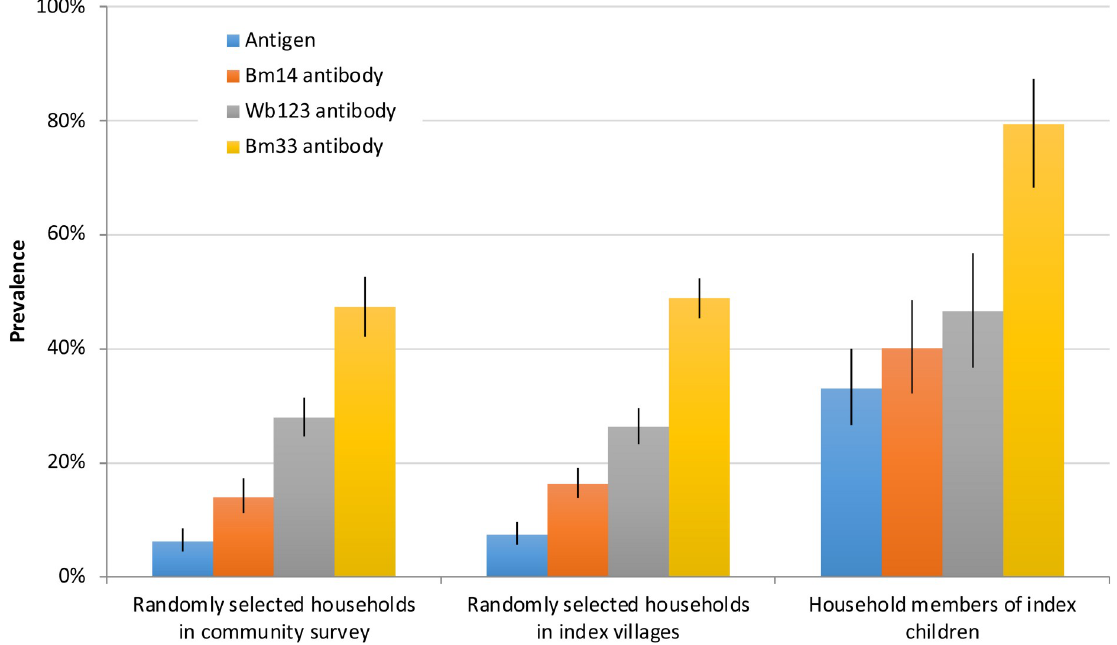
Fig 8. Adjusted seroprevalence of Ag and antibodies in i) randomly selected households in randomly selected villages in community survey (n = 2496 for Ag, 2498 for antibodies), ii) randomly selected households in index villages (n = 924 for Ag, 922 for antibodies), and iii) household members of index children (n = 52 for Ag, 50 for antibodies). To enable direct comparisons, results for all groups were limited to participants aged � 8